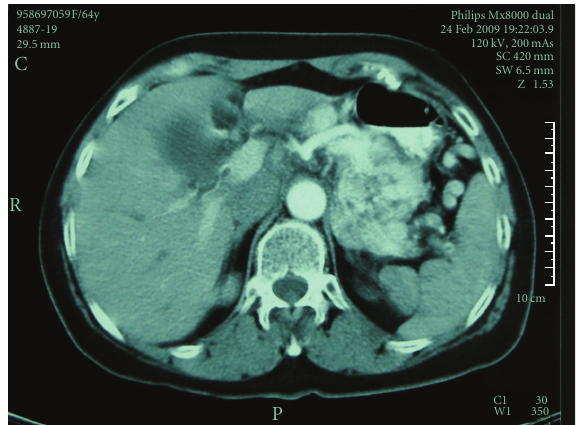
Figure 1: Contrast-enhanced axial CT scan through the pancreas shows a large hypervascular mass in the pancreatic body and tail. Note the presence of dilated perisplenic vessels.